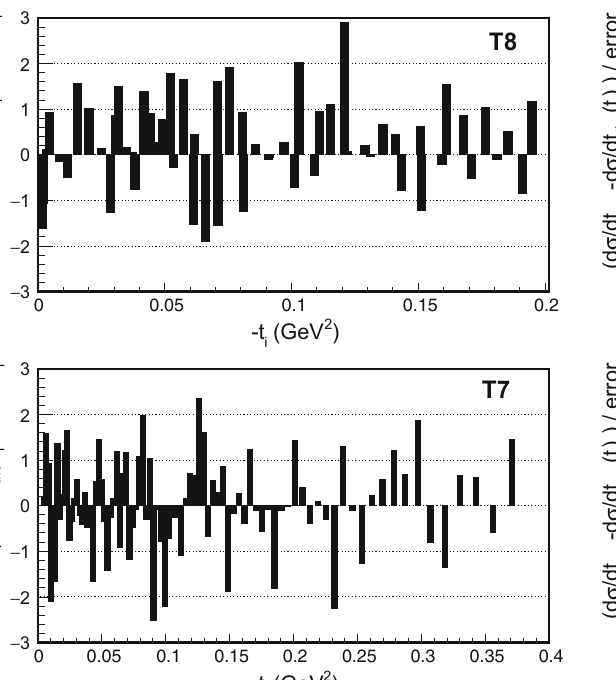
criterion (assuming statistical errors following Gaussian distributions) the best descriptions of the data are concentrated in T8 and T7 experi- ments where about 68% of the experimental points are within 1 sigma deviation from the